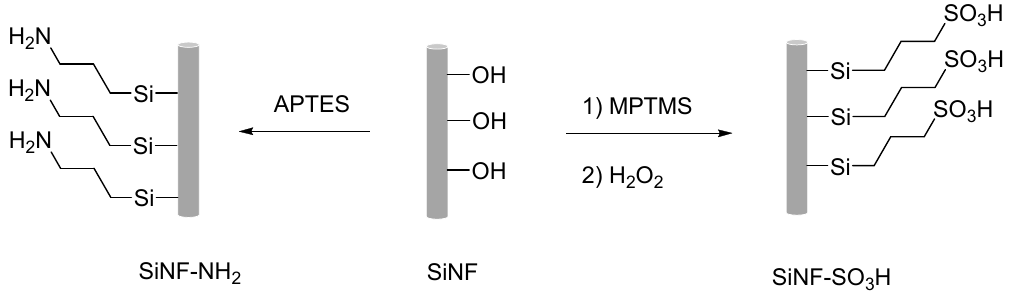
Figure 1. Schematic representation of silica nanofibers modification for preparing nanofibers containing acidic (SiNF–SO 3 H) or basic groups (SiNF–NH 2